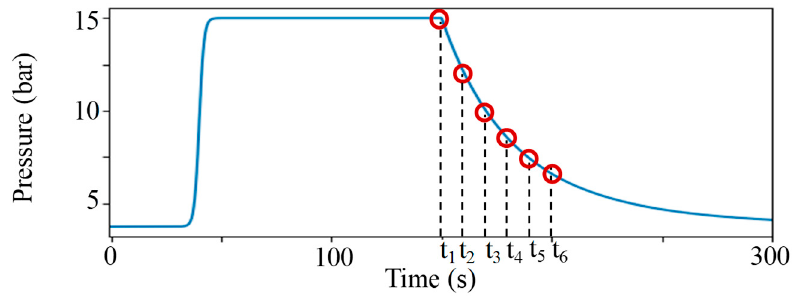
Figure 13. Graph of feed pressure evolution applied to the spiral wound module. Table 3. Corresponding times and pressure in the simulation.